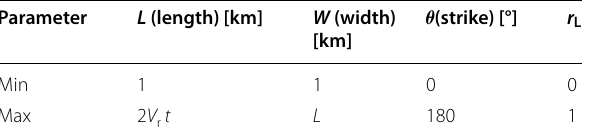
Table 1 Search range of the parameters for line- source and rectangle-source models